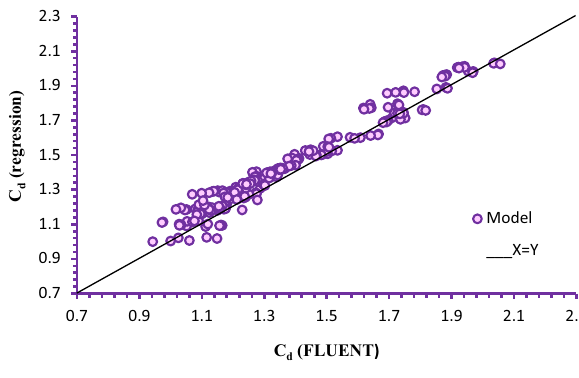
Fig. 15 Scatter plot of discharge coefficients obtained from of Fluent and Eq. (23)